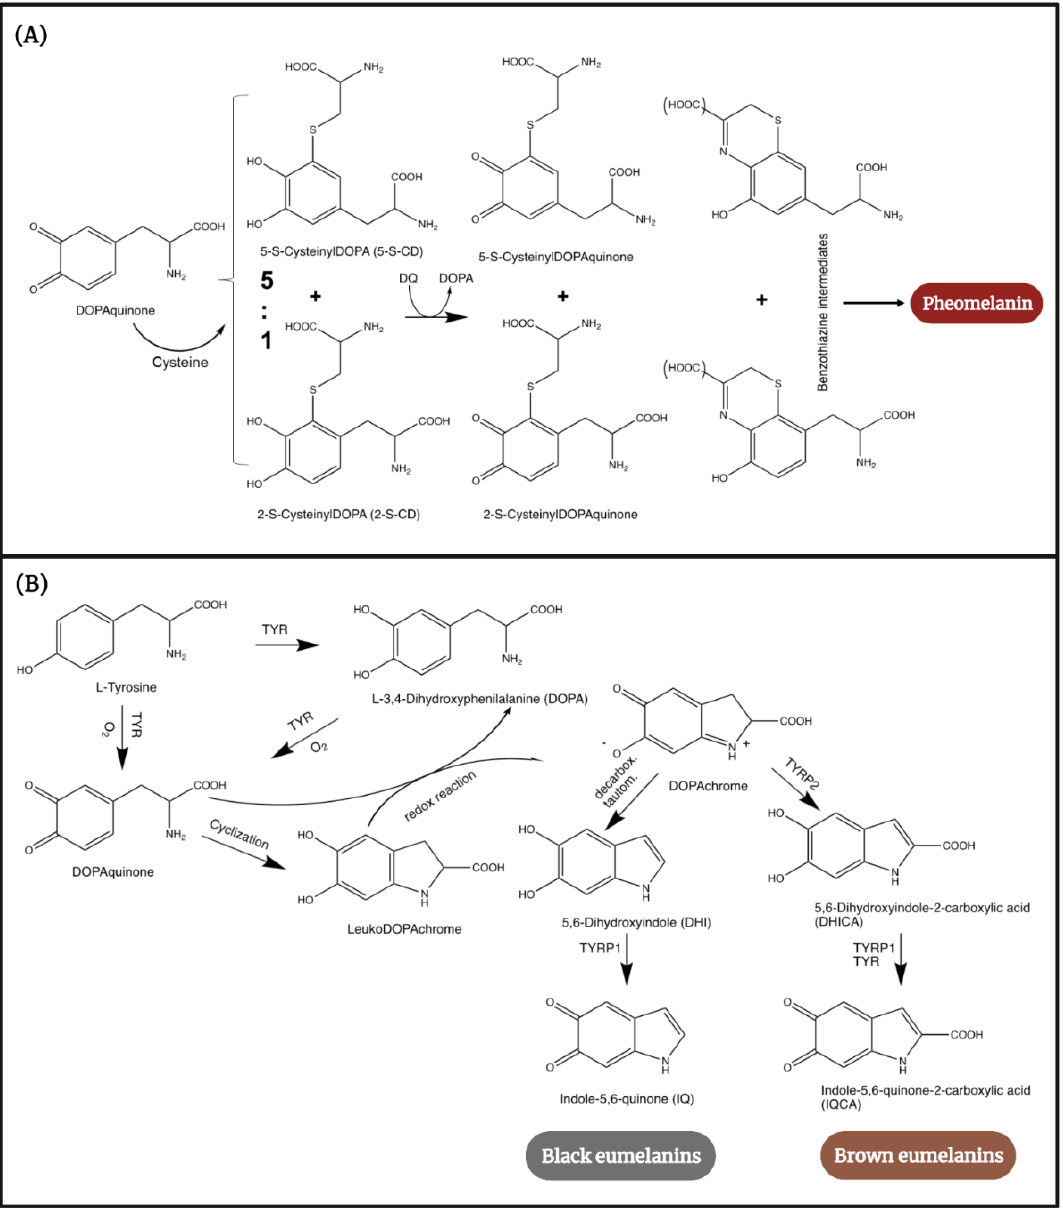
Figure 1. Illustration of the cascade of biochemical reactions participatory to the synthesis of the human melanins ( A ) pheomelanin and ( B ) eumelanin. This image was created using BioRender (BioRender.com). The chemical structures were drawn using ChemDraw 20.1. TYR—tyrosinase, TYRP1—tyrosinase-related protein 1, TYRP2—3,4-dihydroxyphenylalaninechrome tautomerase (Dct).